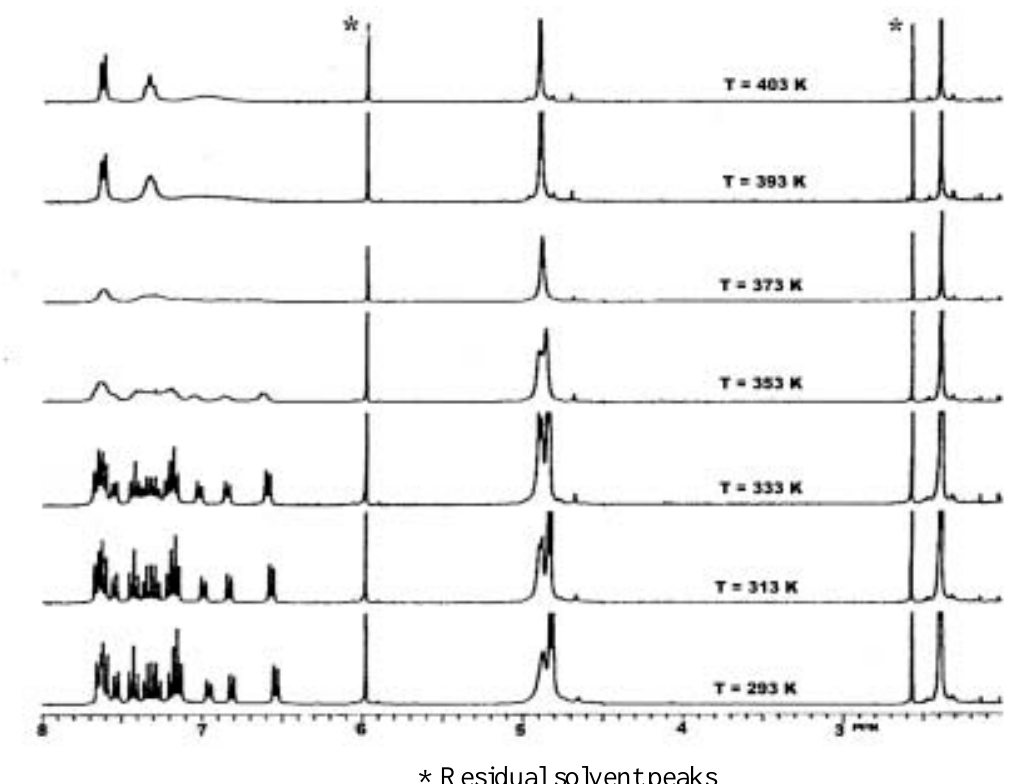
* Residual solvent